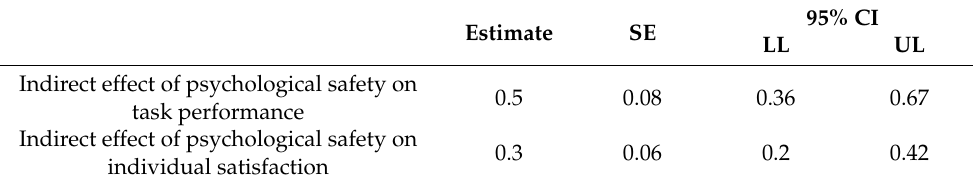
Table 7. Indirect effects and bootstrap results controlled for team size and management team